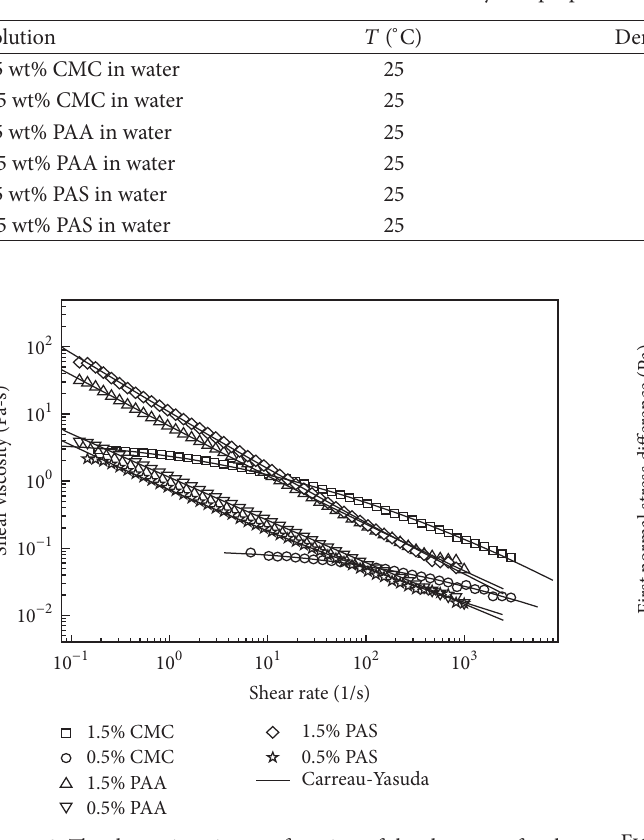
Table 2: Physical properties of viscoelastic fluids.